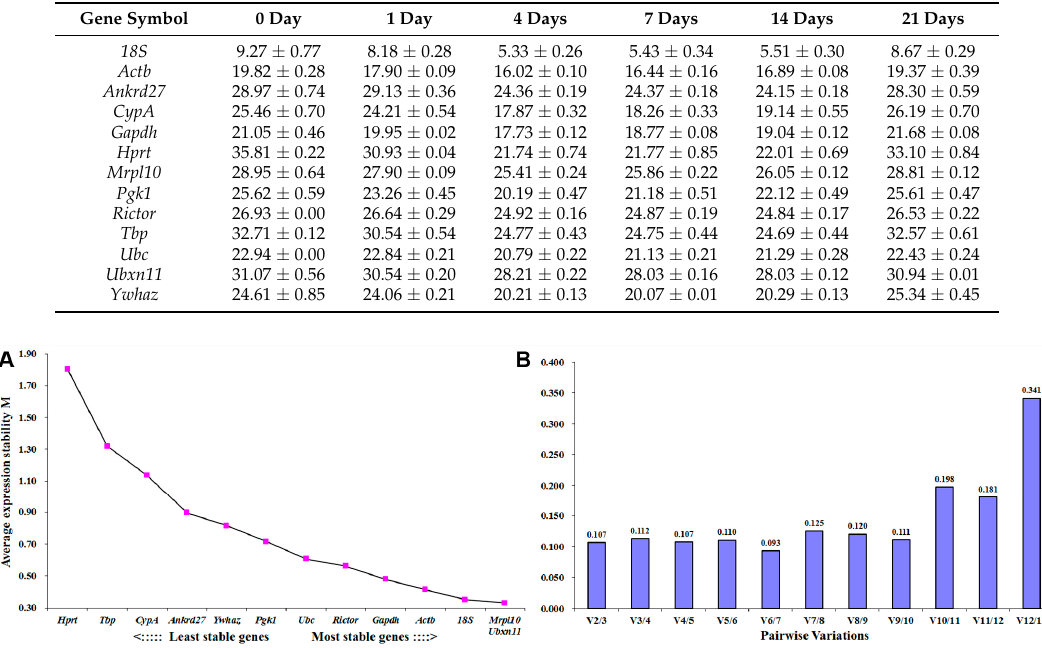
Figure 2. geNorm determined expression stability of candidate housekeeping genes in distal sciatic nerve samples. ( A ) Average expression stability (M) values of tested housekeeping genes. The lower M value, the higher the gene stability; ( B ) The determination of the optimal number of control genes for accurate normalization by using pairwise variation (V) analysis. Histograms indicated the variation values when other endogenous housekeeping genes were added according to the stability order in ( A ).